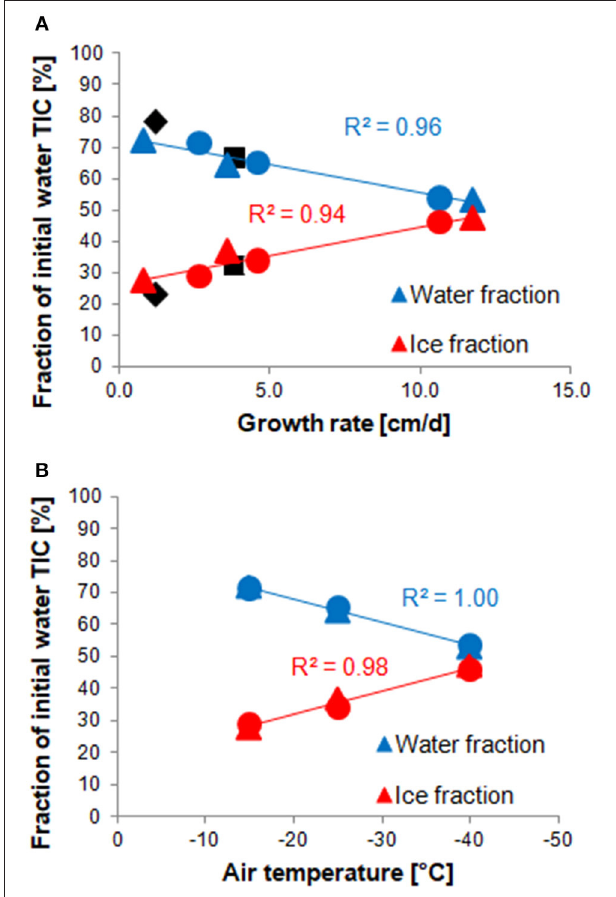
FIGURE 7 | Correlations between the TIC fraction in water (blue) or ice (red) and the average ice growth rate (A) or the ambient temperature (B) of each experiment. Values from stirred runs are marked with round, those from unstirred runs with triangular, symbols. Values measured by previous studies are shown in black, but have not been used for the regression. Black diamonds show values presented by Rysgaard et al. (2007), squares are the (average) results of Nomura et al. (2006). The air temperatures shown in panel B are average values measured during each run, as listed in Table S1 .